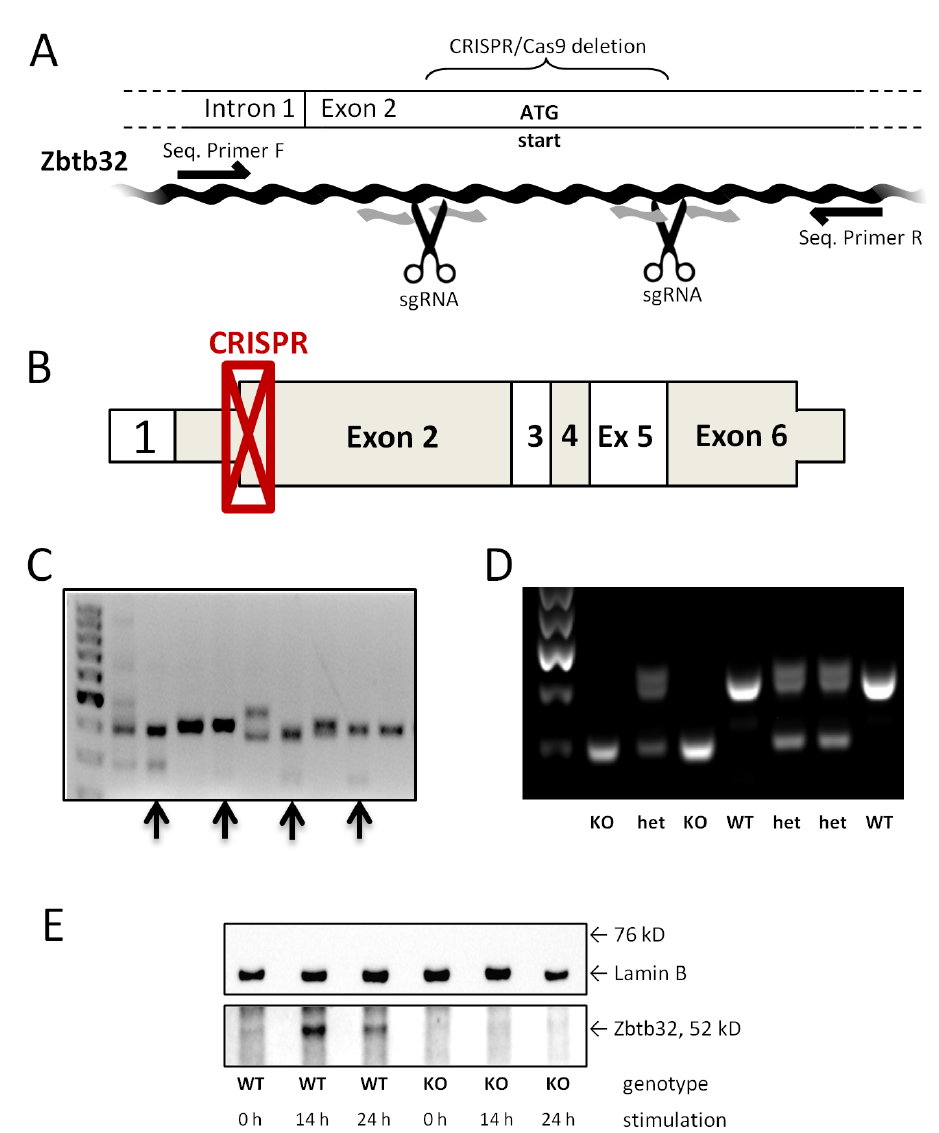
Figure 1. Confirmation of CRISPR-mediated knockout of Zbtb32. The CRISPR/Cas9 technique was used to target exon 2 of the Zbtb32 gene directly in NOD mice. A portion of the Zbtb32 gene was deleted and a frameshift introduced in NOD mice using the CRISPR/Cas9 technique, as illustrated here ( A ). The scissors represent the location of cutting based on sgRNA binding and black arrows indicate binding sites for the standard primers, which were used for both sequencing and genotyping. The location of the deletion maps onto the beginning of exon2 of the wildtype mRNA ( B ). Non-coding portions are shown as thinner than the coding portions. The CRISPR/Cas9-treated embryos develop into mice with genetic mosaicism of the Zbtb32 gene in the F0 generation. Four genetically heterogeneous females (indicated with black arrows) were examined further before one mutant allele was chosen to establish the NOD.Zbtb32 -/- colony ( C ). The targeted deletion of Zbtb32 removed 146 bp from exon 2 as shown by genetic screening of knockout, heterozygous, and wildtype animals in the F2 generation ( D ). The loss of the Zbtb32 protein after CRISPR-mediated deletion was confirmed by Western blotting extracts from stimulated CD4 + splenocytes ( E ) (from three biologically independent